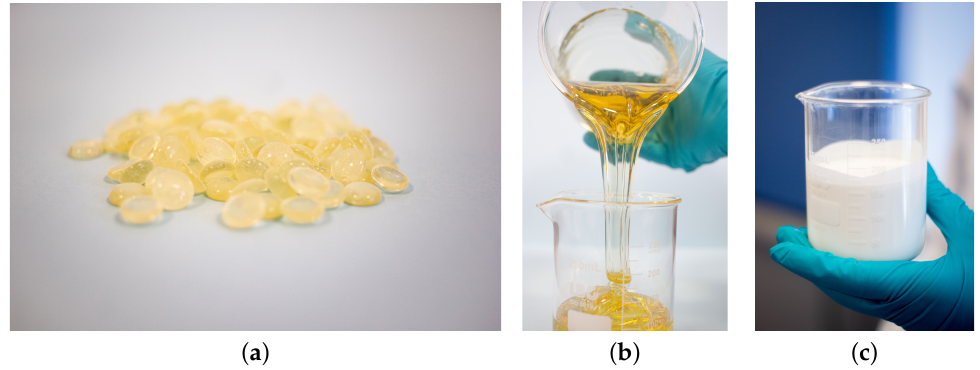
Figure 1. The state of the resin during the process ( a ) as a (solid) raw material; ( b ) after heating to the softening point; ( c ) as a resin-in-water